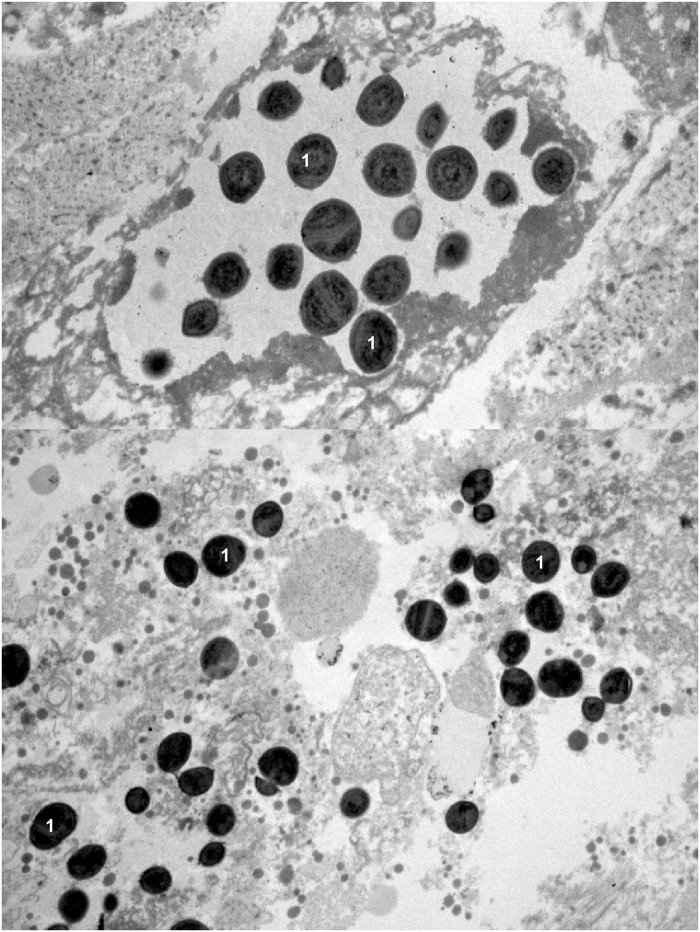
TEM images of two nipple biopsies from women with presumptive signs of “mammary candidiasis”.1, Staphylococcus epidermidis cells. Note the absence of yeasts’ cells.